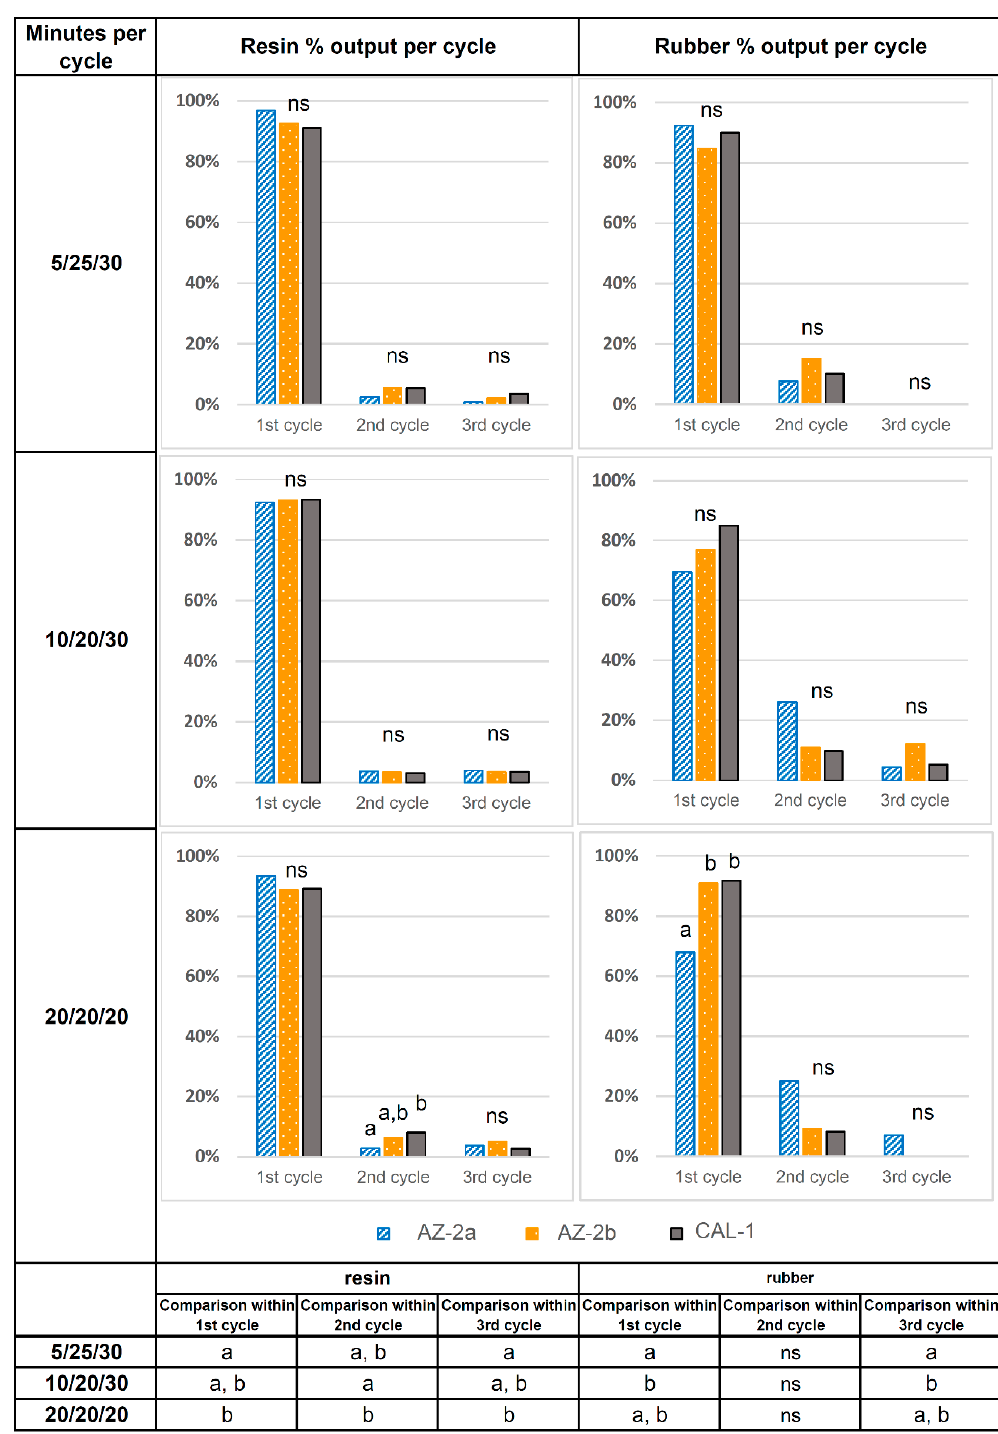
Figure 2. Testing the 3 different cycle schemes in a total extraction time of 60 min for resin extraction and then a total extraction time of 60 min for rubber. Gravimetric yield for resin and rubber in each single stage from the total extracted. Comparisons were made between 2 accessions (AZ-2 and CAL1), with the AZ-2 accession originating from two different plots (AZ-2a and AZ-2b). Different letters in the graph denote significant differences between accessions (AZ-2a, AZ-2b, and CAL1) within cycles, while different letters in columns of the table below denote significant differences between extraction time within the same extraction cycle, both at a 95% level of confidence. ns = non-significant.